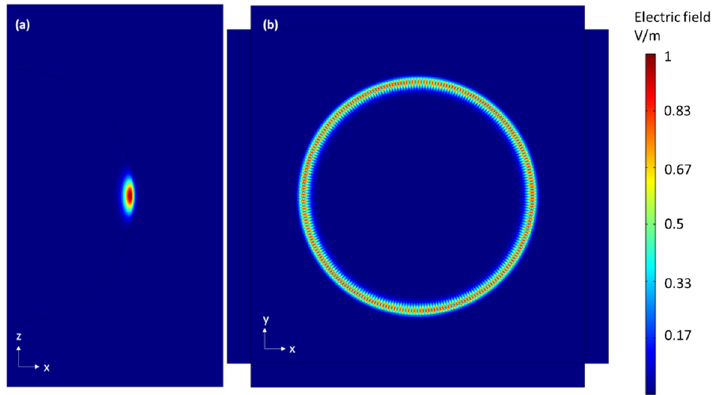
Figure 5. Electric field norm profile of a WGM with TE polarization with n = 1, m = l = 133, λ = 826.63 nm with ( a ) z axisymmetric simulation and ( b ) transversal simulation. Color represents electric field intensity normalized in rainbow